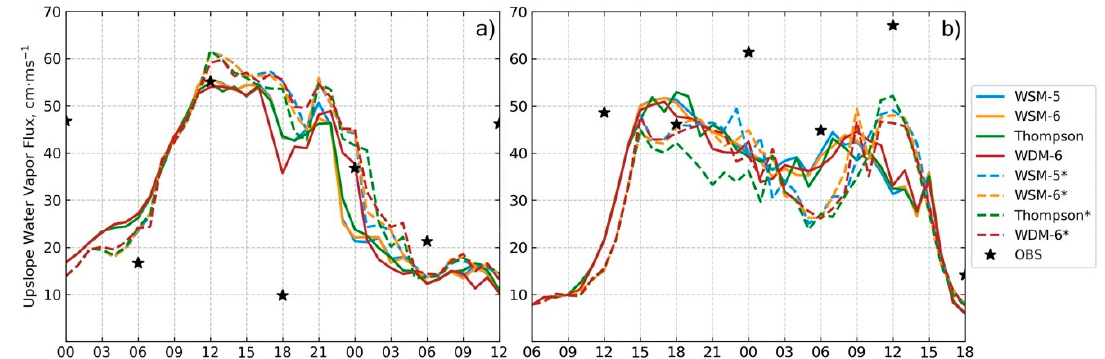
Figure 8. Upslope water vapor flux at Big Basin Redwoods State Park on ( a ) 16 November 2017 starting at 00:00 UTC and ( b ) 6 April 2018 starting at 06:00 UTC. * denotes 1/3 km resolution.